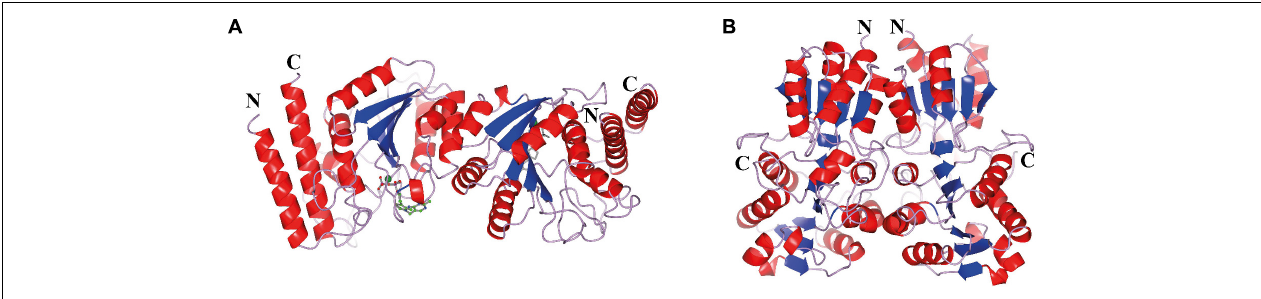
FIGURE 4 | The oligomeric state of the different ChTK polypeptides. (A) The modeled ChTK-N dimer is shown as a cartoon model with the N- and C-termini indicated. The catalytic Ca 2 + is shown as a green sphere and the TPP cofactor as a stick model. (B) The ChTK-C homotetramer as determined by X-ray crystallography is shown as a cartoon model with N- and C termini indicated. The helices are shown in red, the strands are shown in blue and the loops in lilac. The Figures 4–7B,C , 8 were prepared using CCP4mg (McNicholas et al., 2011).